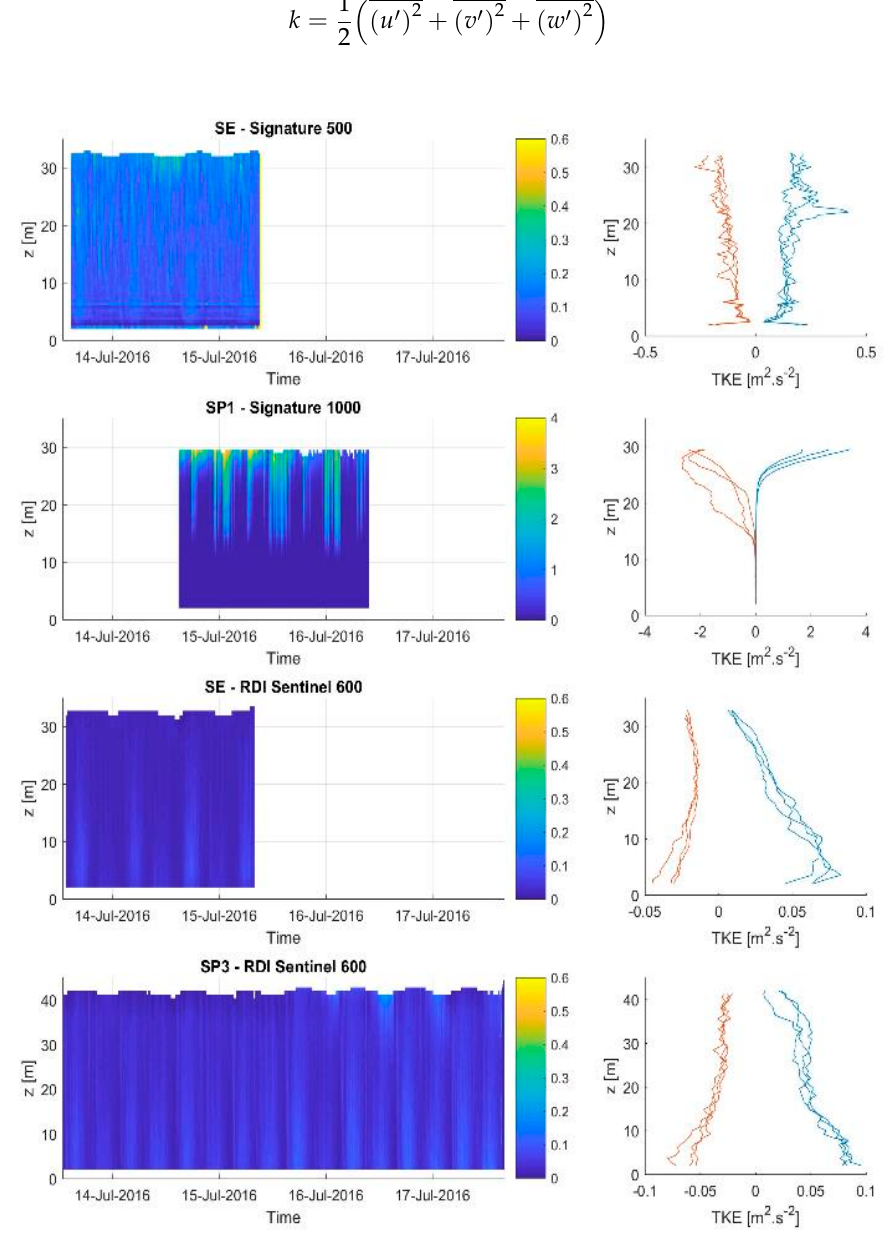
Figure 6. Turbulence kinetic energy. Left: TKE based on 10 min windows for each sensor. Right: TKE for the first three peak velocity flood and ebb tides, where the flood is positive (blue) and the ebb tide negative (red).